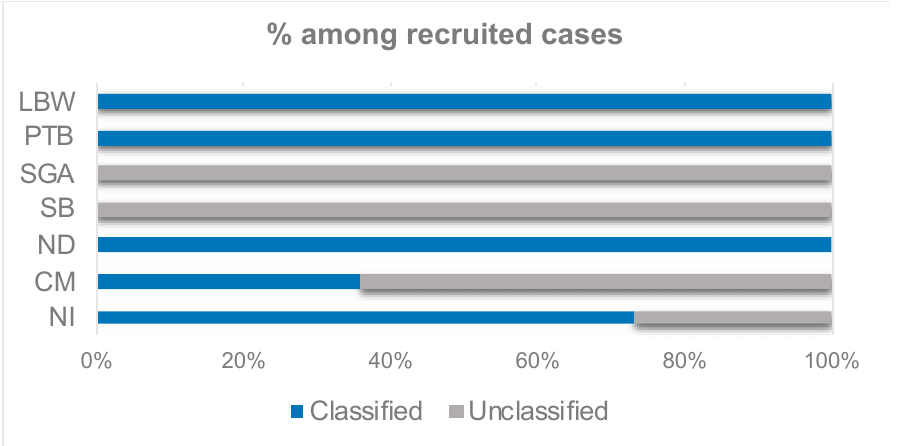
Figure 3. Percentage of classification of the cases recruited in Valencia into any of the diagnostic certainty levels of the GAIA definitions, per neonatal outcome of interest.